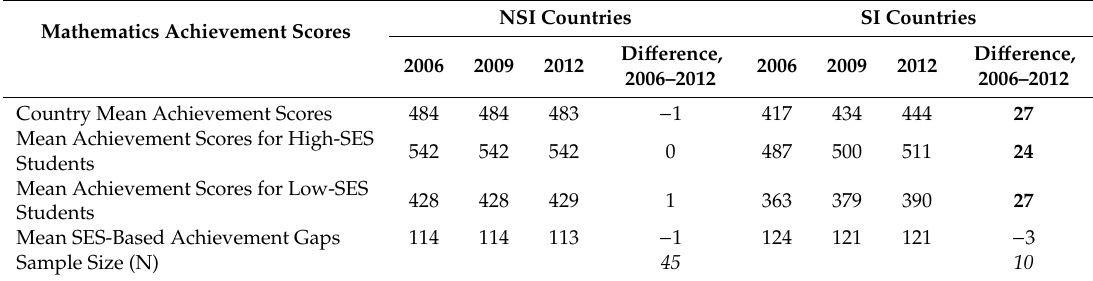
Table 3. Mean PISA mathematics achievement scores of NSI and SI countries,